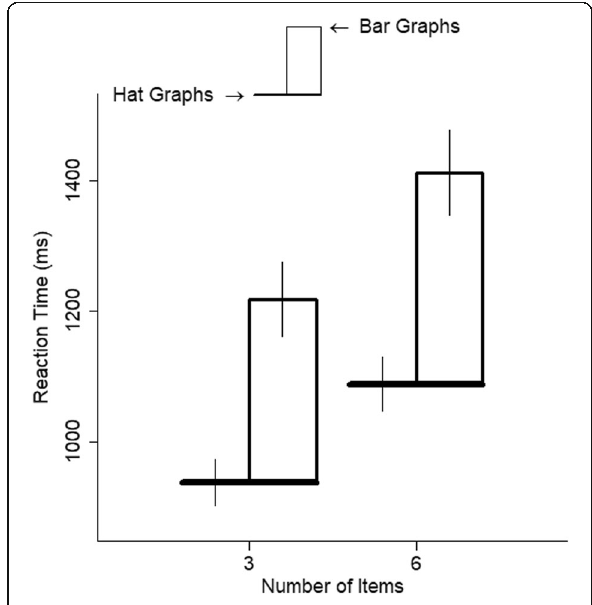
Fig. 3 Reaction time (RT) is plotted as a function of number of items and graph type for experiment 1. The brim of the hat corresponds to the RTs for the hat graph condition, and the top of the crown of the hat corresponds to RTs for the bar graph condition. The size of the crown indicates the difference in RTs between the two conditions. Error bars are ±1 SEM, estimated from the model